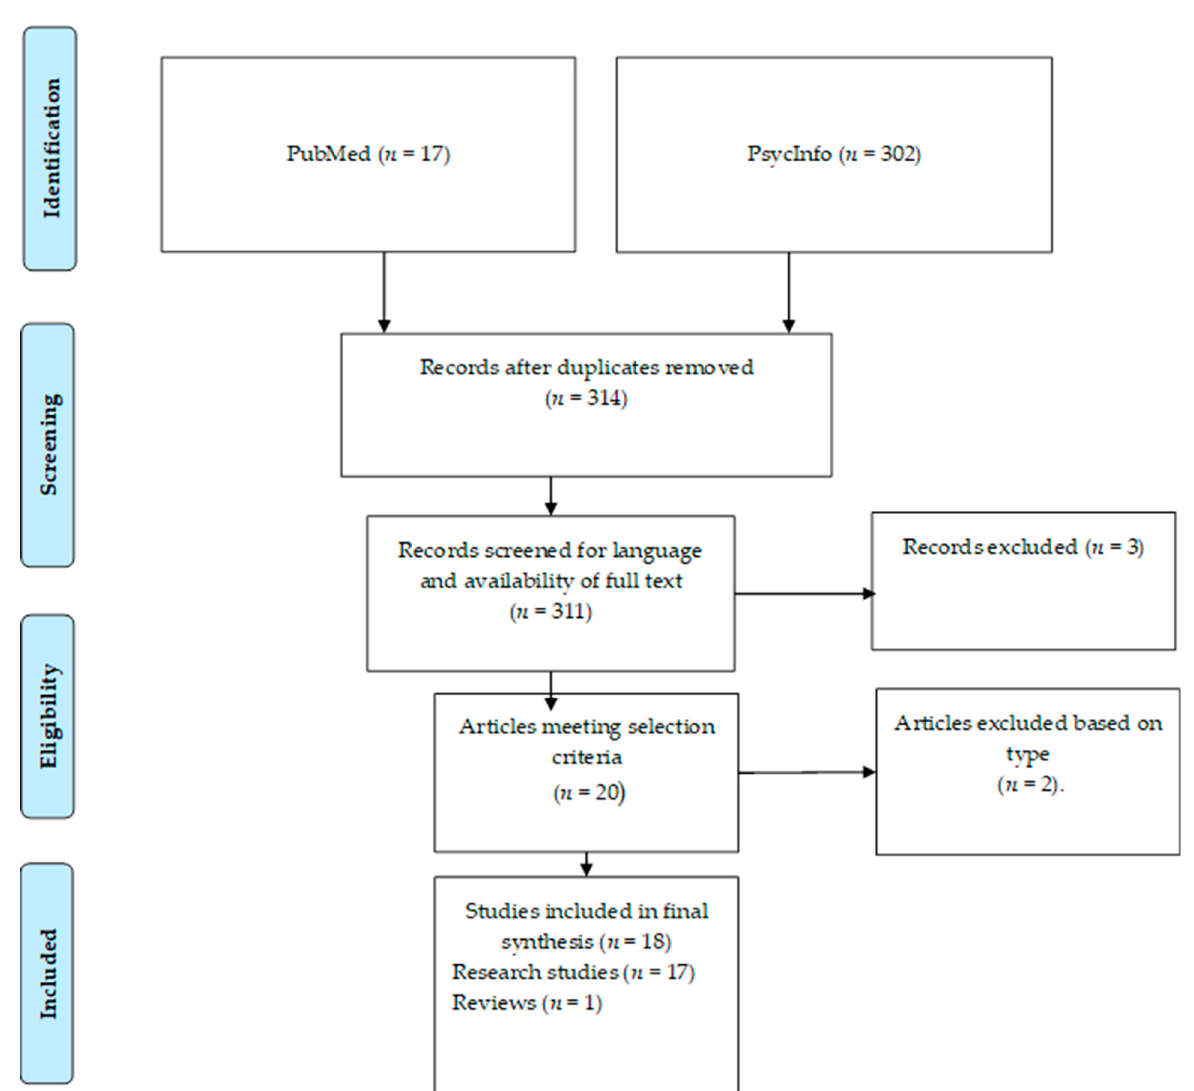
Figure 1. Flow chart indicating the steps taken in the systematic process of article